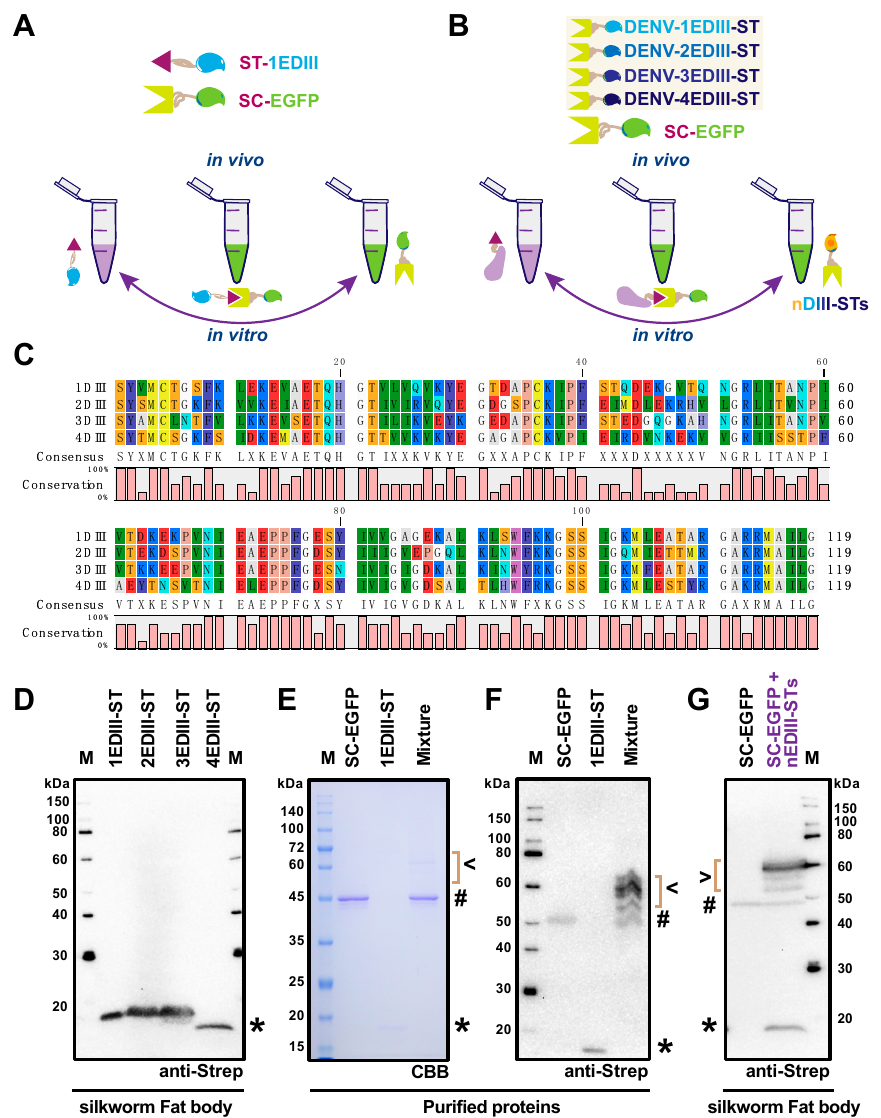
Figure 4. Protein ligation and labeling using silkworm-Spy-BEVS. The scheme of in vitro and in vivo protein ligations was shown in ( A ) (ST-1EDIII) and ( B ) (ST-nEDIIIs) using SC-EGFP. The amino acid alignment of dengue virus E protein domain III (EDIII) from four serotypes was shown in ( C ). The expression of each EDIII-ST in the fat body in baculovirus-infected silkworm larvae was verified by Western blot ( D ). The purified SC-EGFP and 1EDIII-ST were mixed in vitro and the ligated adduct was verified by either CBB-staining ( E ) or Western blot by anti-Strep ( F ). Super co-infection with five recombinant viruses containing SC-EGFP and four EDIII-STs (nEDIII-STs) was employed to explore the ability of in vivo ligation for multiple proteins of interest. The resulting products were identified by Western blot along with the SC-EGFP single infection control ( G ). # and * indicate SC-EGFP and nEDIIIs, respectively. Ligated products were marker by the brace and the completed adduct was marked by